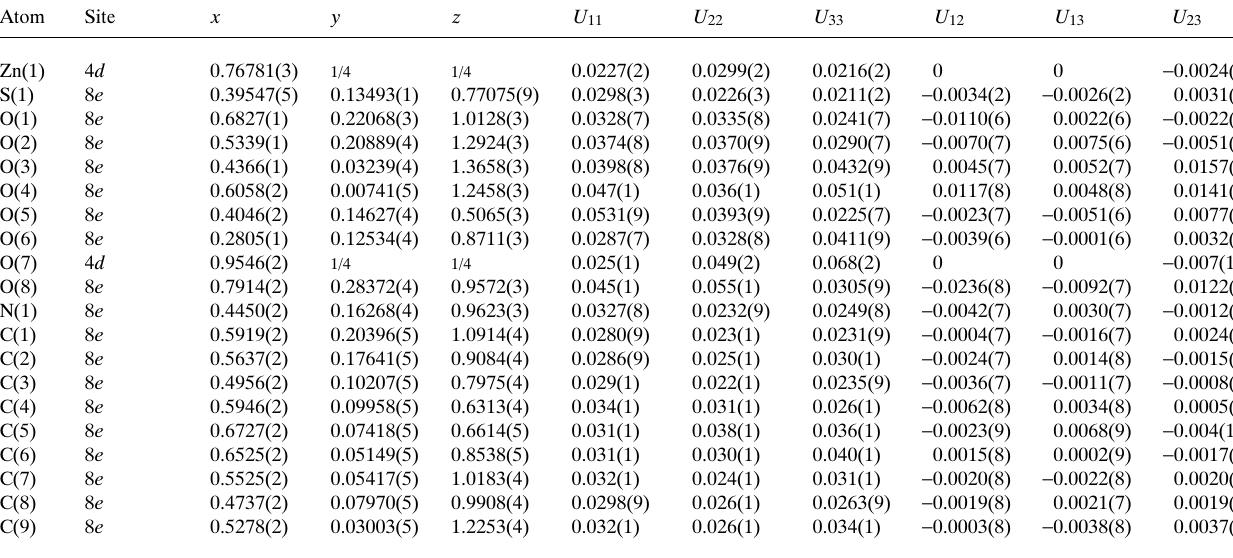
Table 3. Atomic coordinates and displacement parameters (in Å 2 ) .